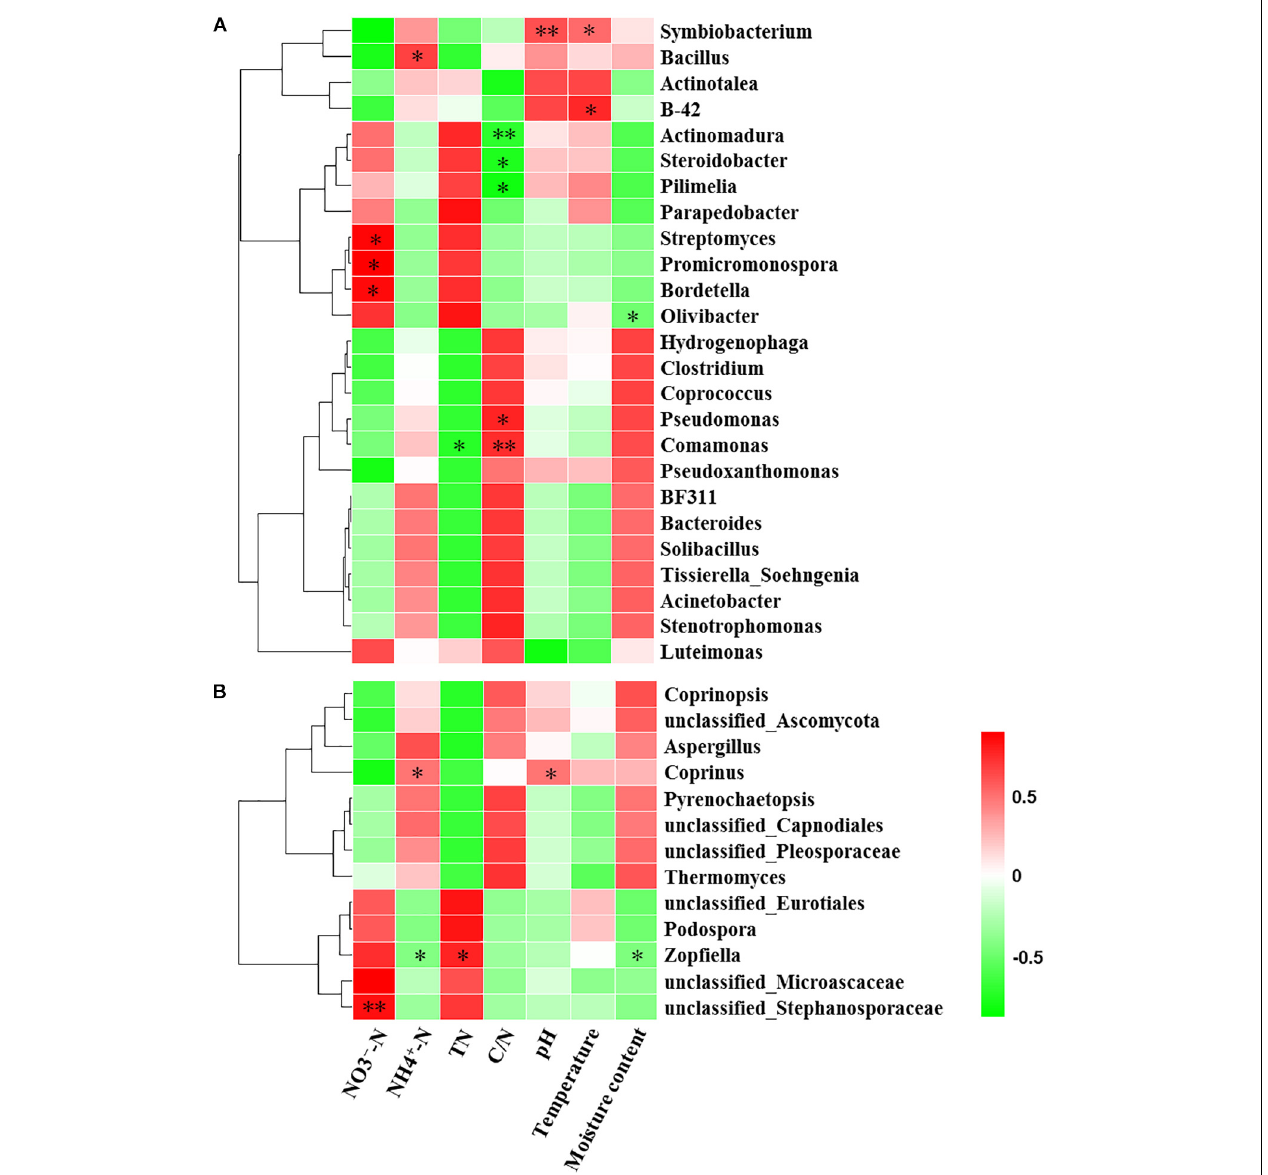
FIGURE 7 | Pearson correlation heatmap of composting physicochemical parameters and the main genera (relative abundance > 1%) of bacterial (A) and fungal (B) . TN, total nitrogen; C/N, the ratio of TC to TN; ∗ Significant at P < 0.05; ∗∗ Significant at P <